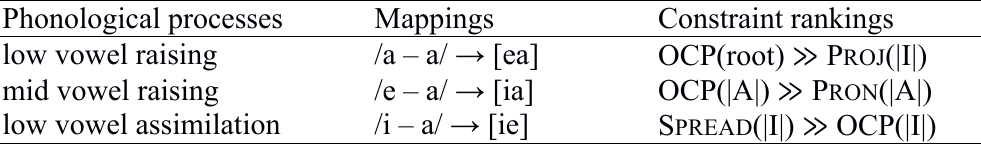
Table 3 . Constraint rankings for the three considered phonological